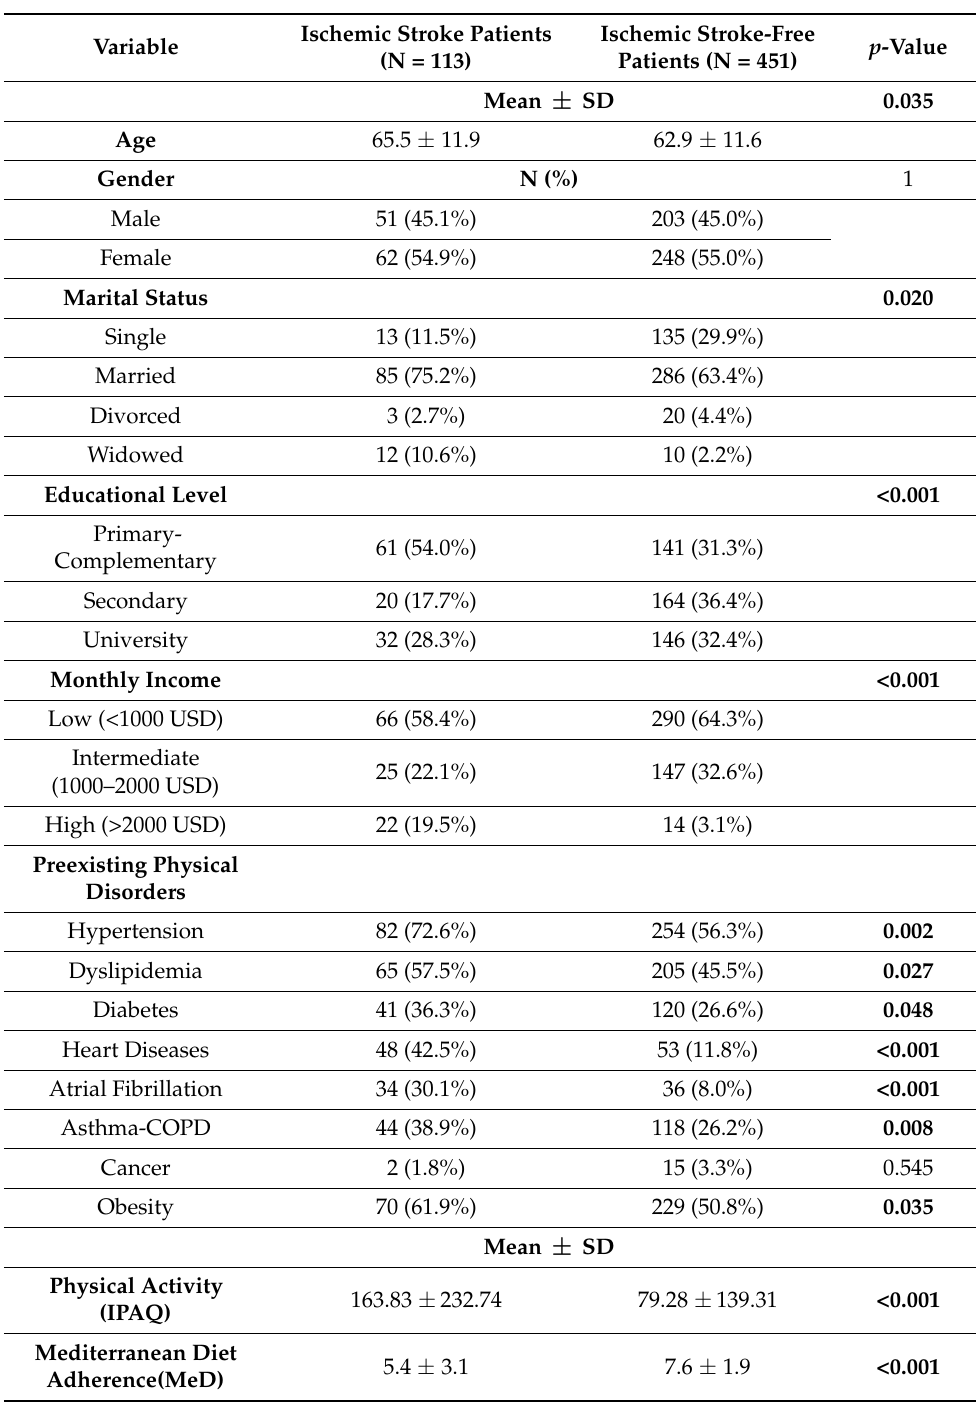
Table 1. Bivariate analysis of demographic factors associated with ischemic